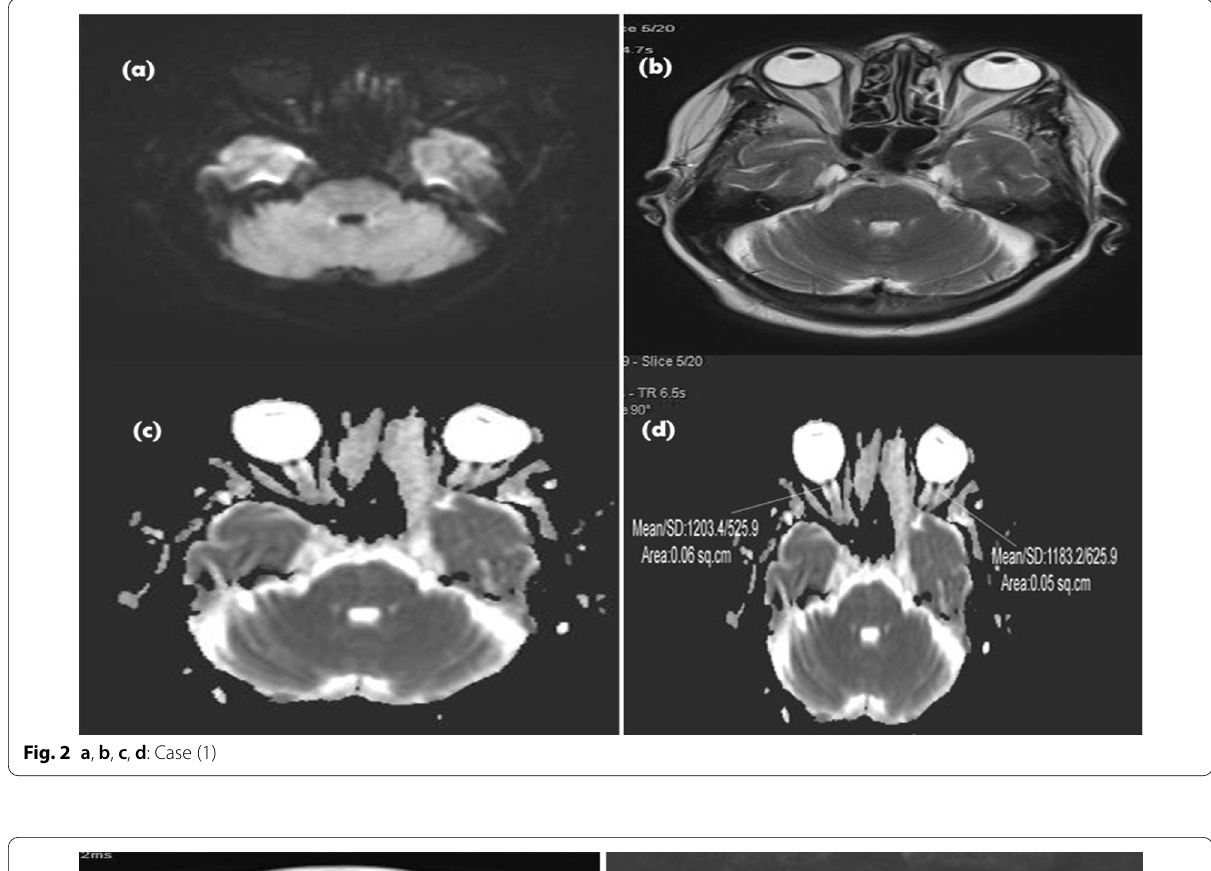
Fig. 2 a , b , c , d : Case (1)